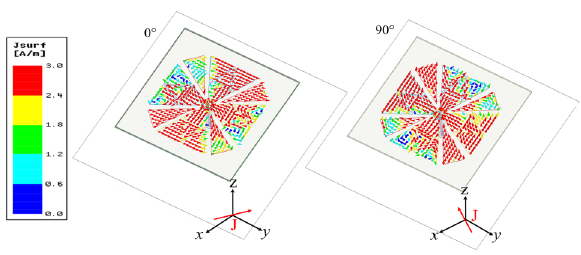
Figure 5. Current distribution on the parasitic patches of antenna 3 at 6.25 GHz.